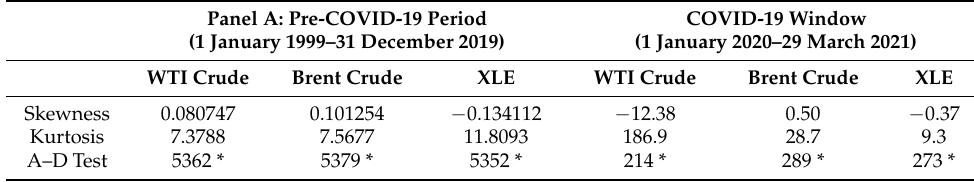
Table 2. Distribution